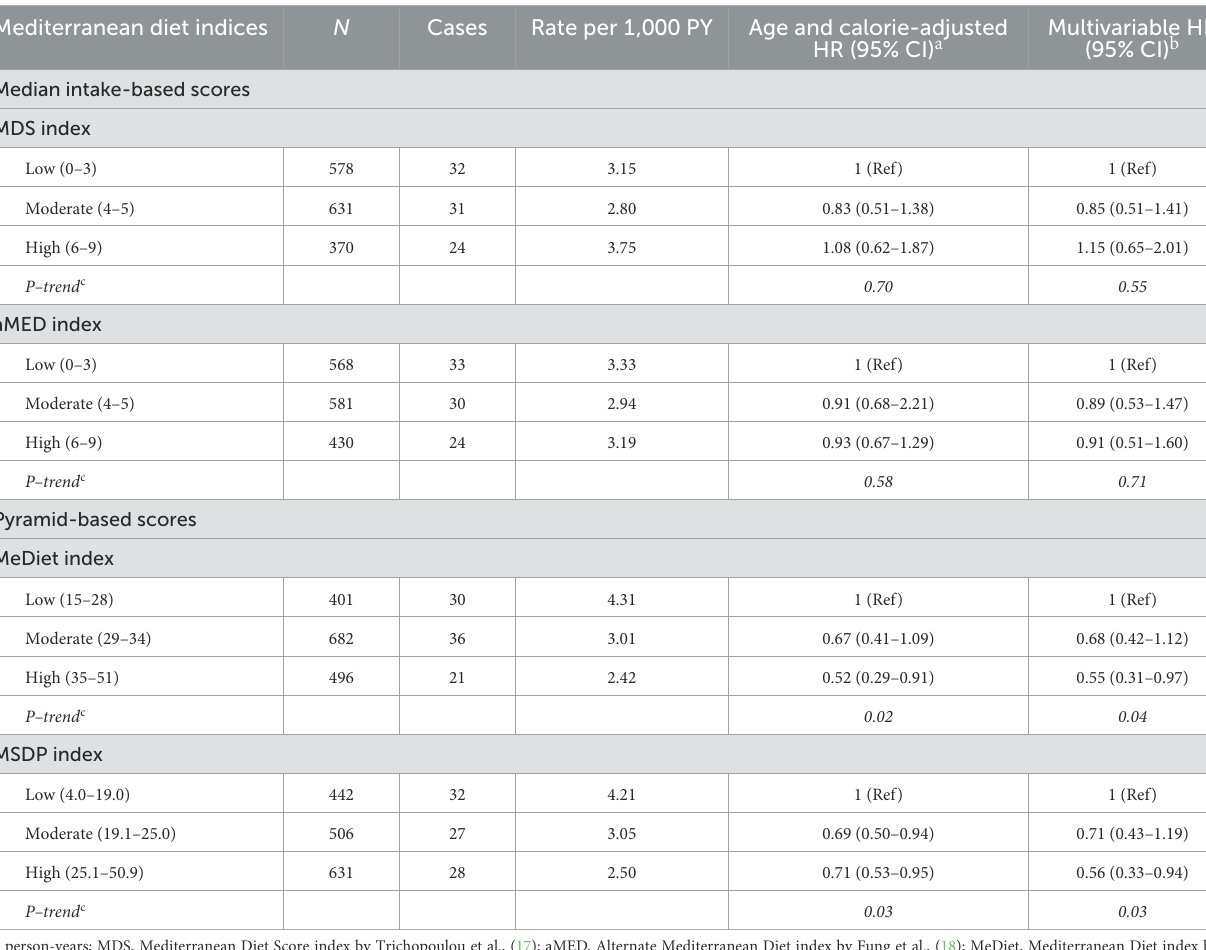
TABLE 3 Hazard ratios for breast cancer associated with Mediterranean diet indices. Mediterranean diet